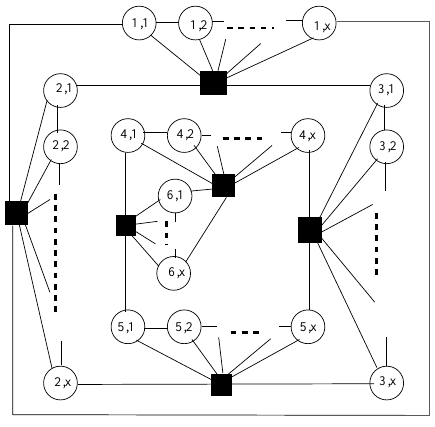
Figure 1. A plane graph G with four levels of vertices.